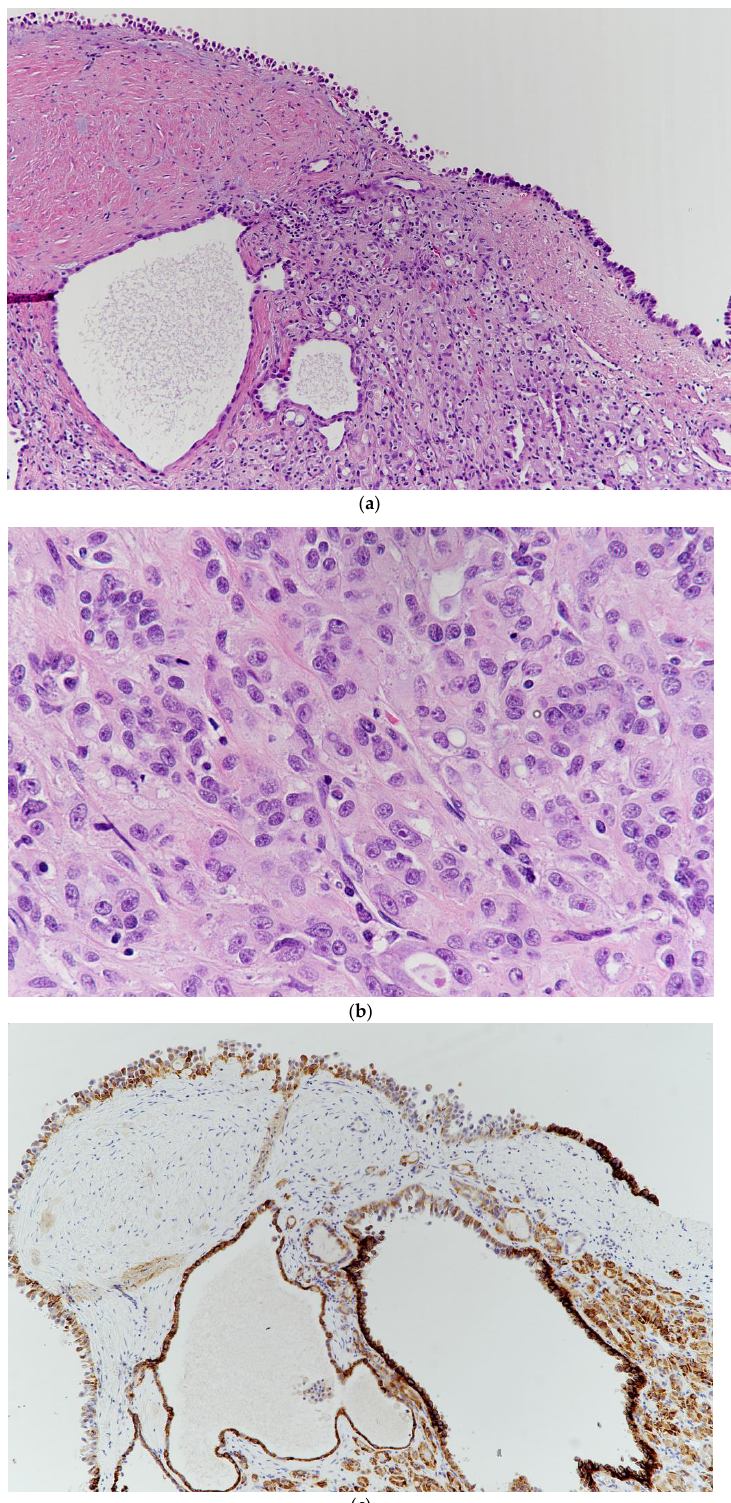
Figure 2. The tumor comprised a mixture of variably sized cysts and tubules (left side). The right side showed poorly differentiated tumors. (H&E stain, ×20).